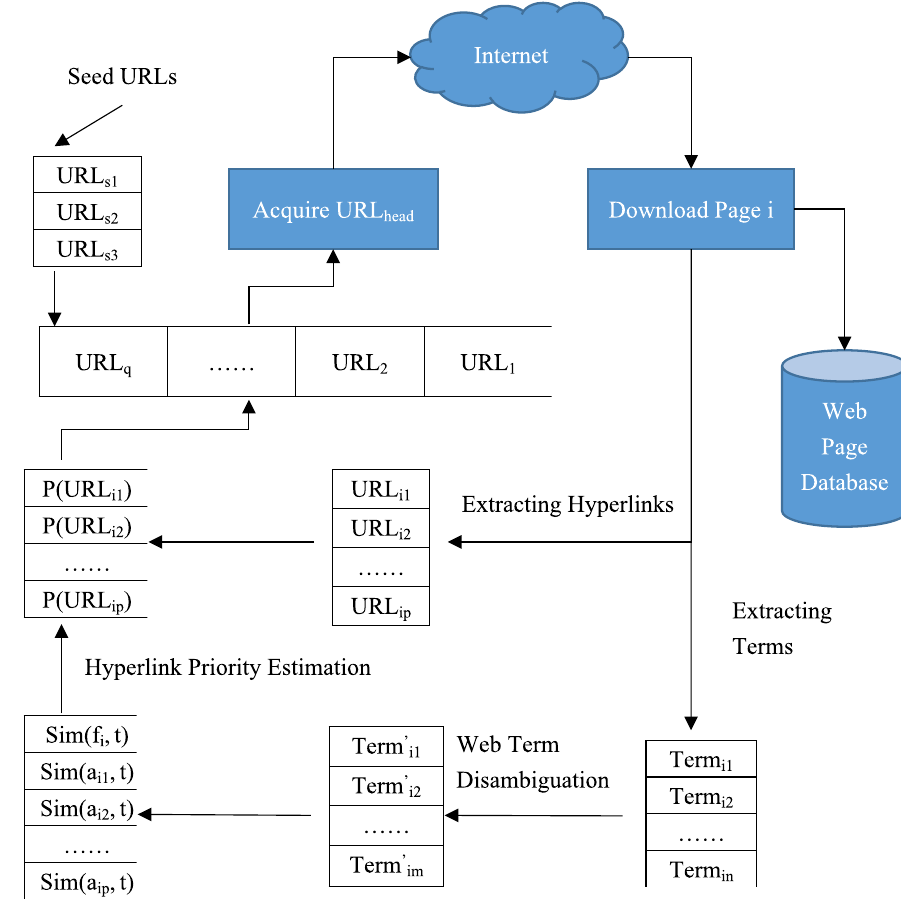
Fig. 6 The example of downloading web pages for the proposed focused